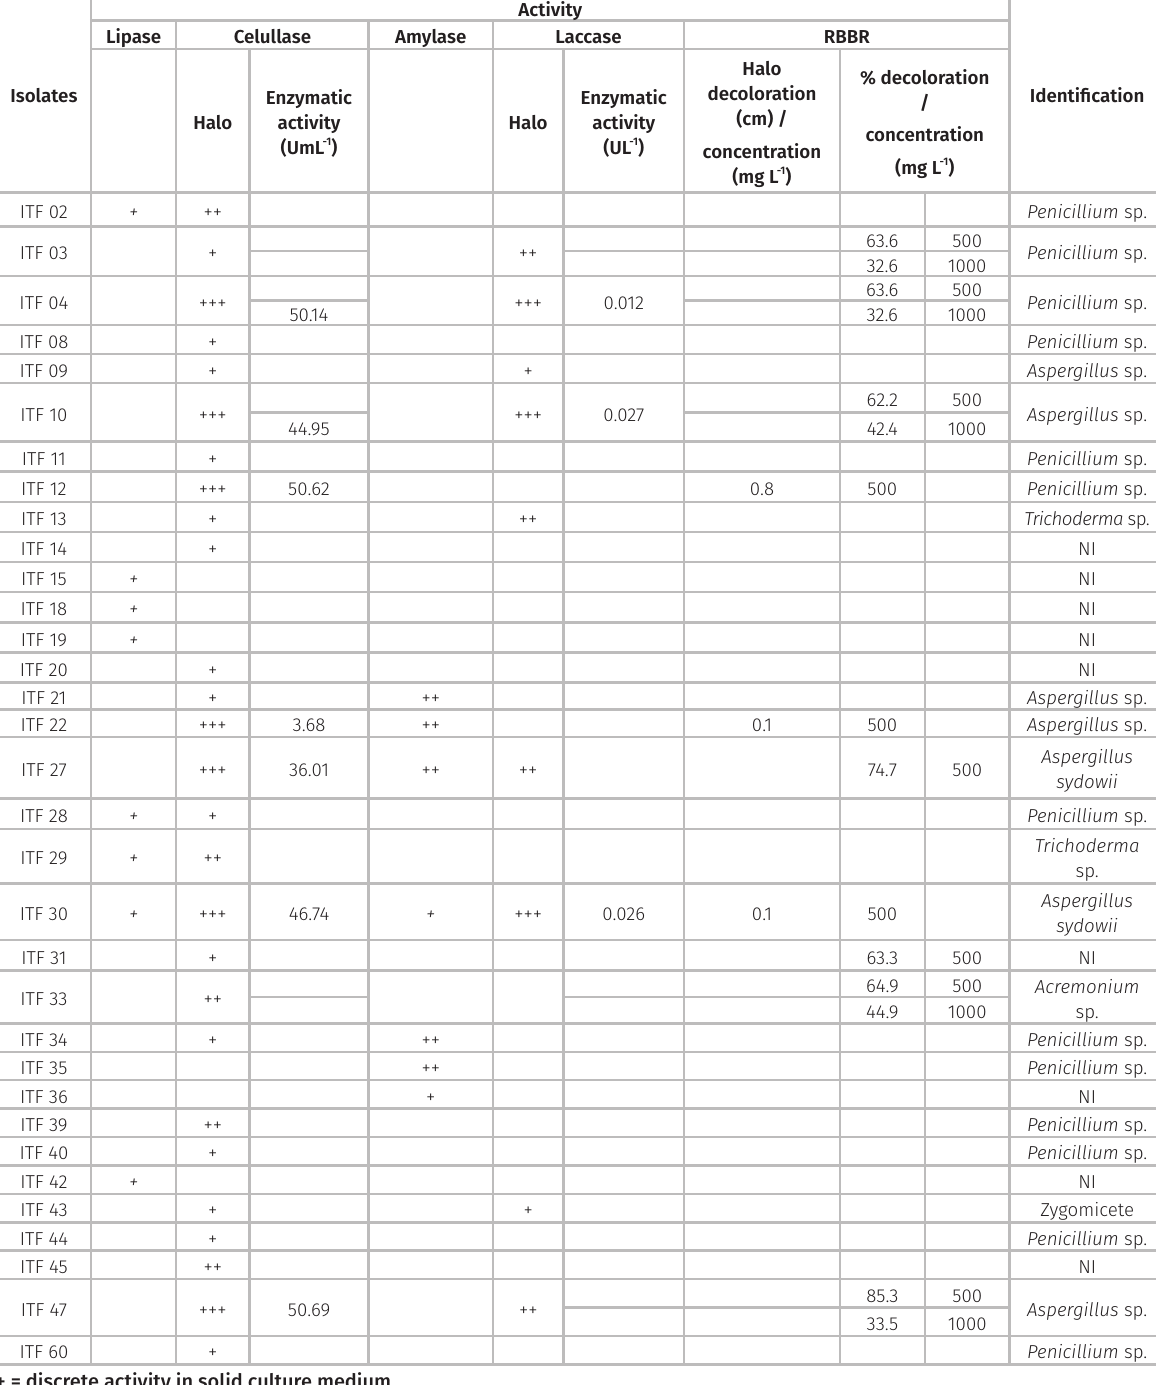
Table I. Results of the best enzyme producing strains and/or capable of discoloration of the RBBR dye and their morphological